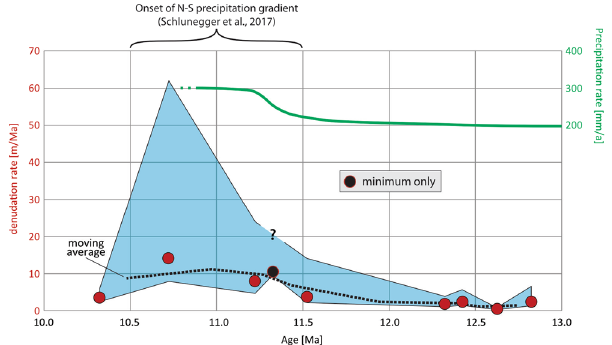
Figure 3. 10 Be-inferred paleo-denudation rates of the Western Cordillera between 13–10 Ma. The light blue shaded area shows the 1 σ solution space. The black dashed line displays the 2-samples moving average. The precipitation rates reconstructions inferred by Schlunegger et al . 22 are plotted in green on the right vertical axis. This figure was drawn using the software Adobe Illustrator ® CS5 (www.adobe.com/products/illustrator.html), licensed to the University of